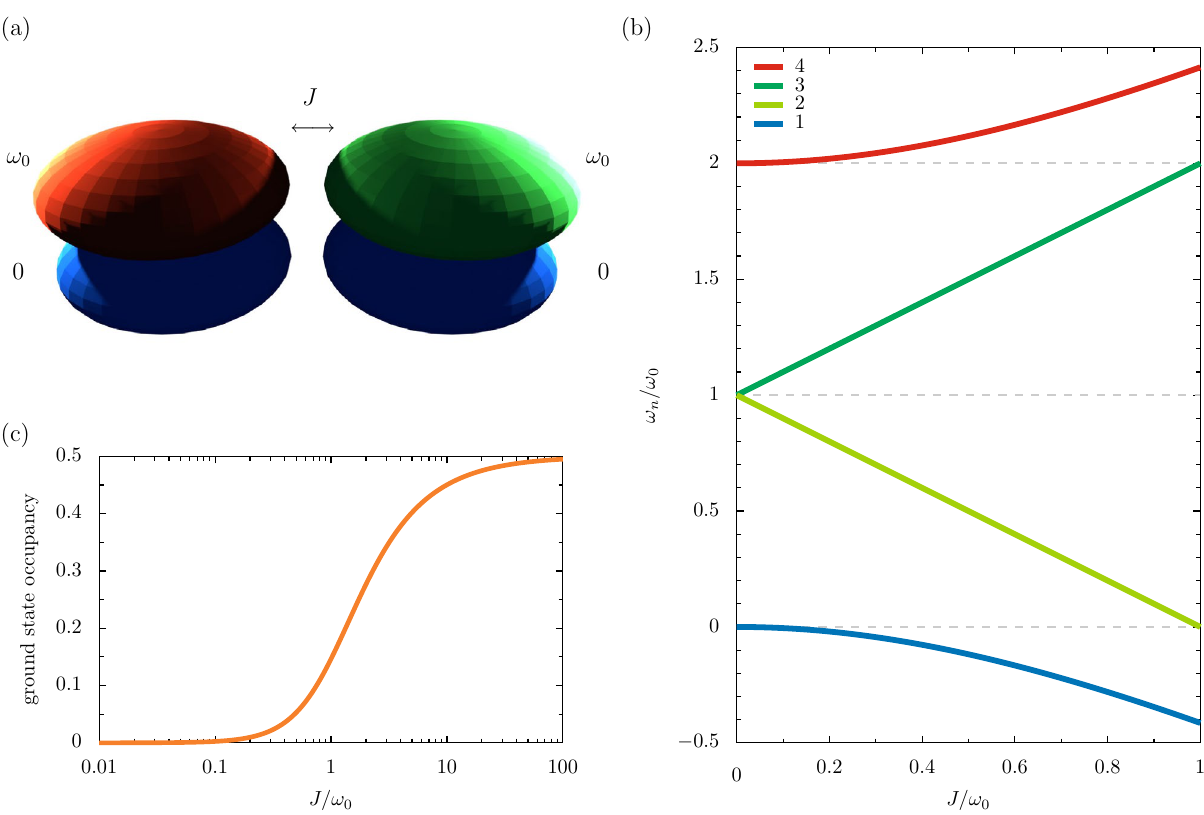
Figure 1. Ultrastrong coupling in the dimer. Panel ( a ): a sketch of a pair of two-level systems, each of bare transition frequency ω 0 , with the qubit-qubit coupling strength J [cf. Eq. (1)]. Panel ( b ): the eigenfrequencies ω n , as a function of J [cf. Eq. (2)]. Dashed grey lines: the transition frequencies in the uncoupled limit. Panel ( c ): the ψ 1 occupancy of the ground state as a function of J [cf. Eq. || ��